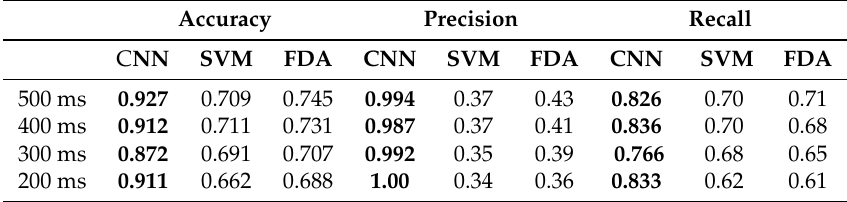
Table 5. Comparison between the overall accuracy rates, precision and recall obtained for the CNN model with the highest accuracy rate, support vector machines (SVM) and Fisher’s discriminant analysis